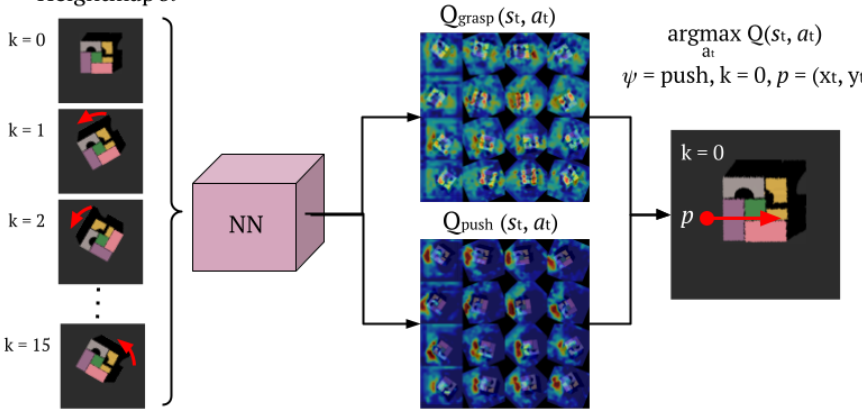
Figure 3. Data pipeline in the system. Each complete forward pass consists of 16 distinct forward passes through the NN. The input heightmaps (RGBD data) are rotations of the correspondent k value. The output of the system is 2 Q-value maps per each forward step, for a total of 32 maps. Out of these, the k map, of the action, presenting the maximum pixel Q-value identify the chosen action to